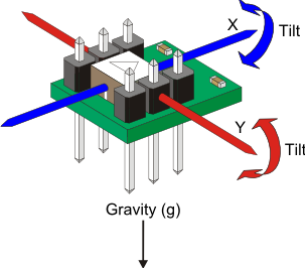
Figure 3. Accelemeter